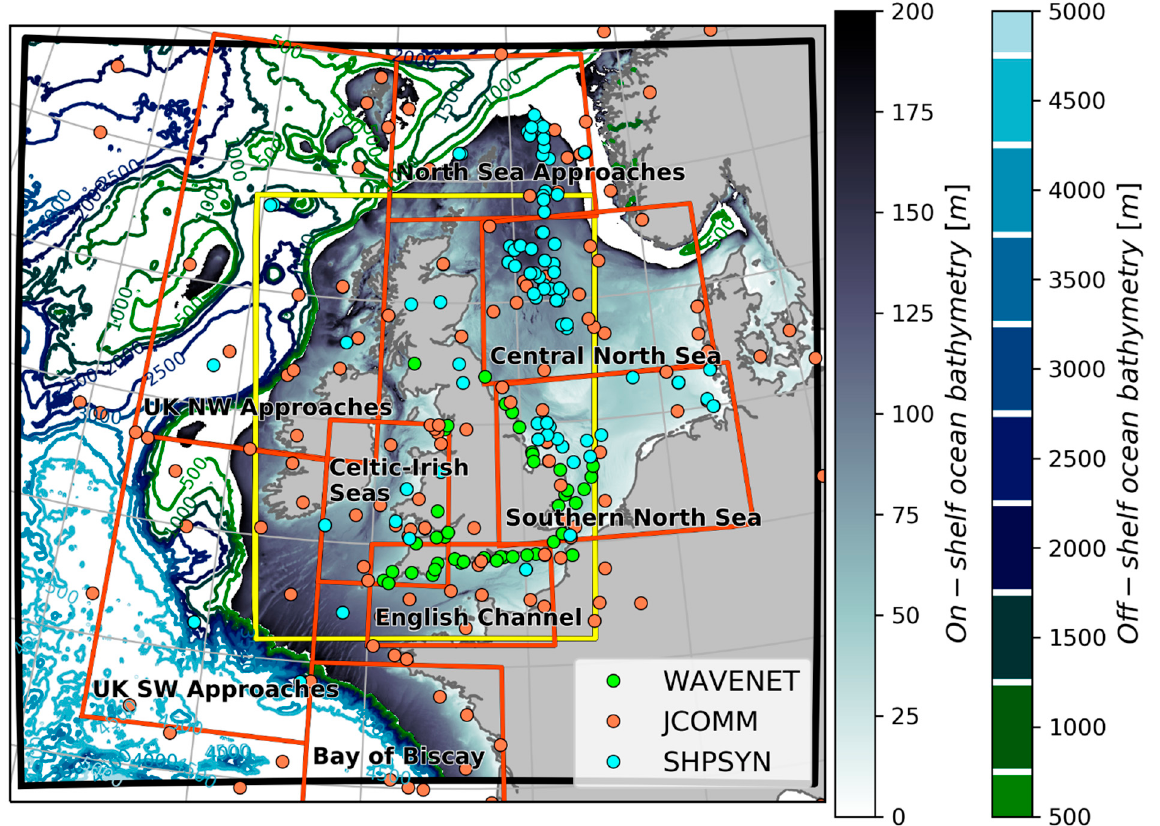
Figure 1. North-west (NW) shelf physical context and model domain. The NW shelf domain (black boundary) includes atmosphere, ocean and wave components; the inner region (1.5 × 1.5 km) of the Met Office Unified Model (UM) atmosphere model domain is also presented (yellow boundary). In-situ observations are shown as solid dots and areas for analysis across the model domain are indicated in red. In-situ observations comprise the Joint WMO IOC Commission for Oceanography and Marine Meteorology’s operational Wave Forecast Verification Scheme (JCOMM), Ship Synop Observations at fixed platforms (SHPSYN) and UK WAVENET and Chanel Coastal Observatory (CCO) in-situ observations for coastal waters (WAVENET).